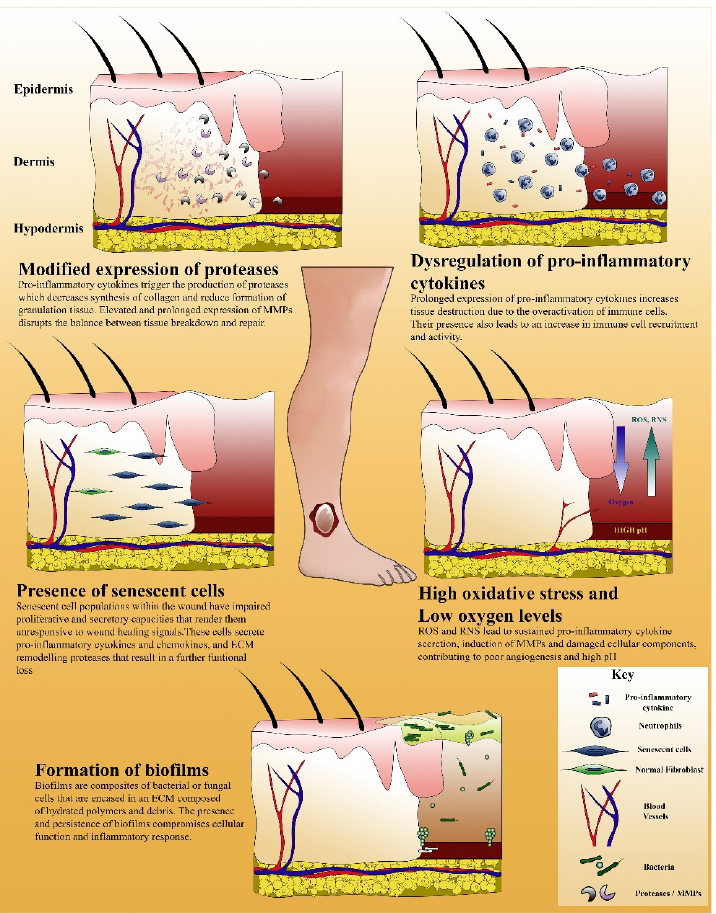
Figure 3. An illustration that summarizes the elements of perturbed healing found in chronic wounds. Reprinted from Ref. [37] with permission from Elsevier. License Number: 5063251014605.